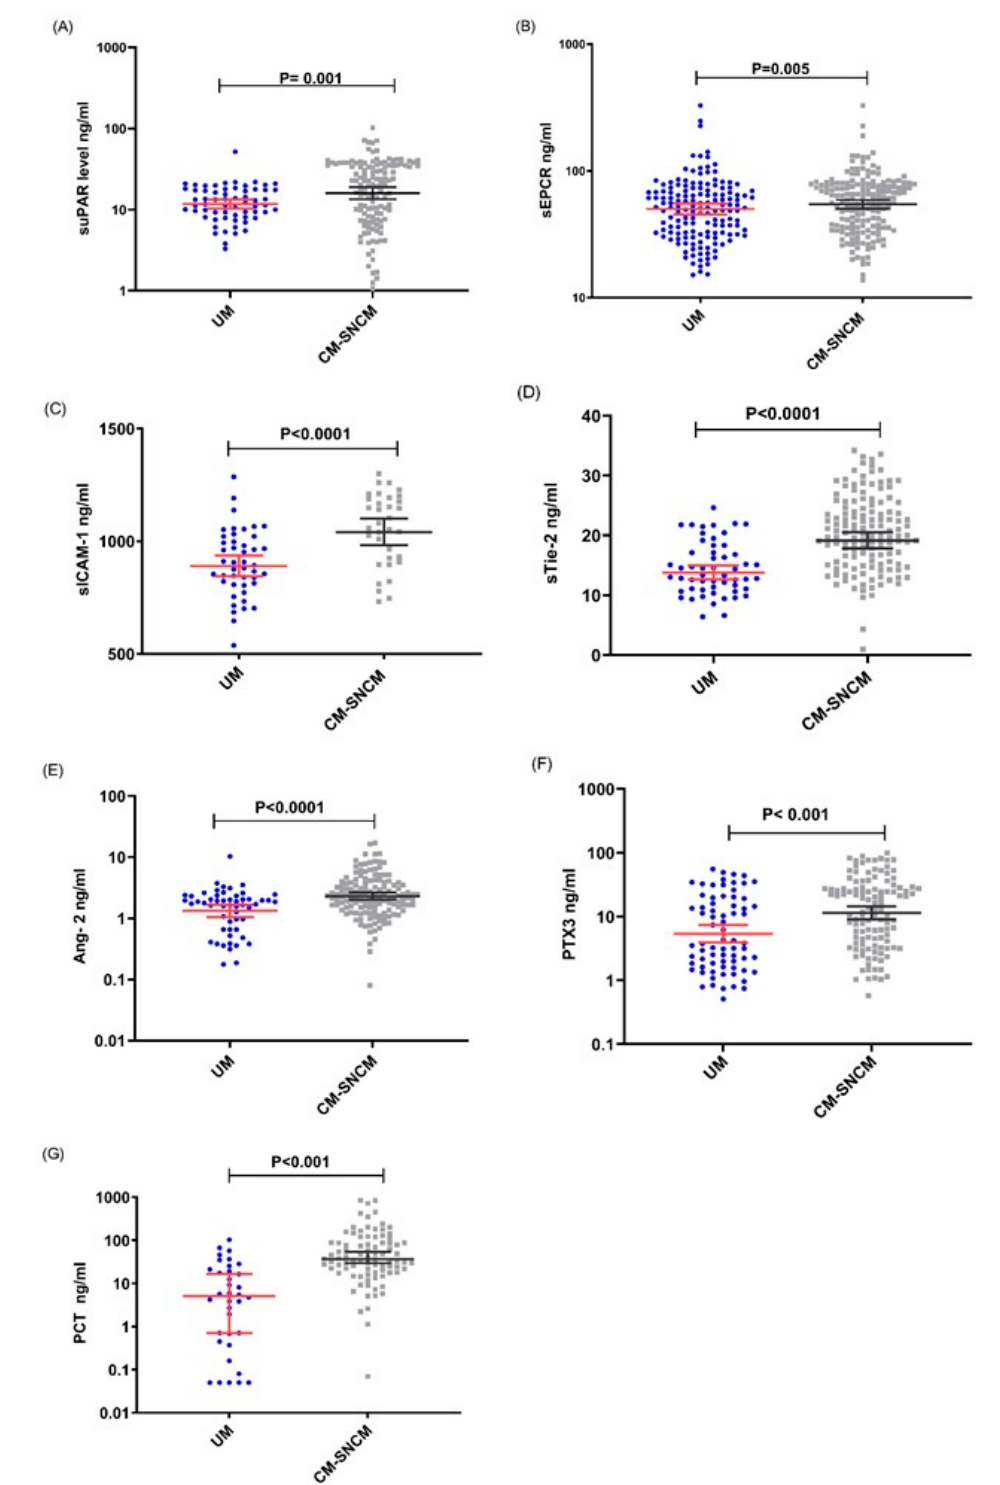
Figure 1. Plasma levels of suPAR, sEPCR, sICAM-1, sTie-2, Ang-2, PTX3 and PCT in children with uncomplicated malaria (UM) and in children with cerebral malaria or severe non-cerebral malaria (CM-SNCM). ( A – G ), Plasma levels of ( A ) suPAR, ( B ) sEPCR, ( C ) sICAM-1, ( D ) sTie-2, ( E ) Ang-2, ( F ) PTX3 and ( G ) PCT obtained in children with uncomplicated malaria (UM) (blue dots) and cerebral malaria or severe non-cerebral malaria (CM-SNCM) (gray squares) on the day of admission to hospital as measured by ELISA. Data are presented as dot plots with median with (95% CI). The Mann–Whitney U-test was performed for each comparison .